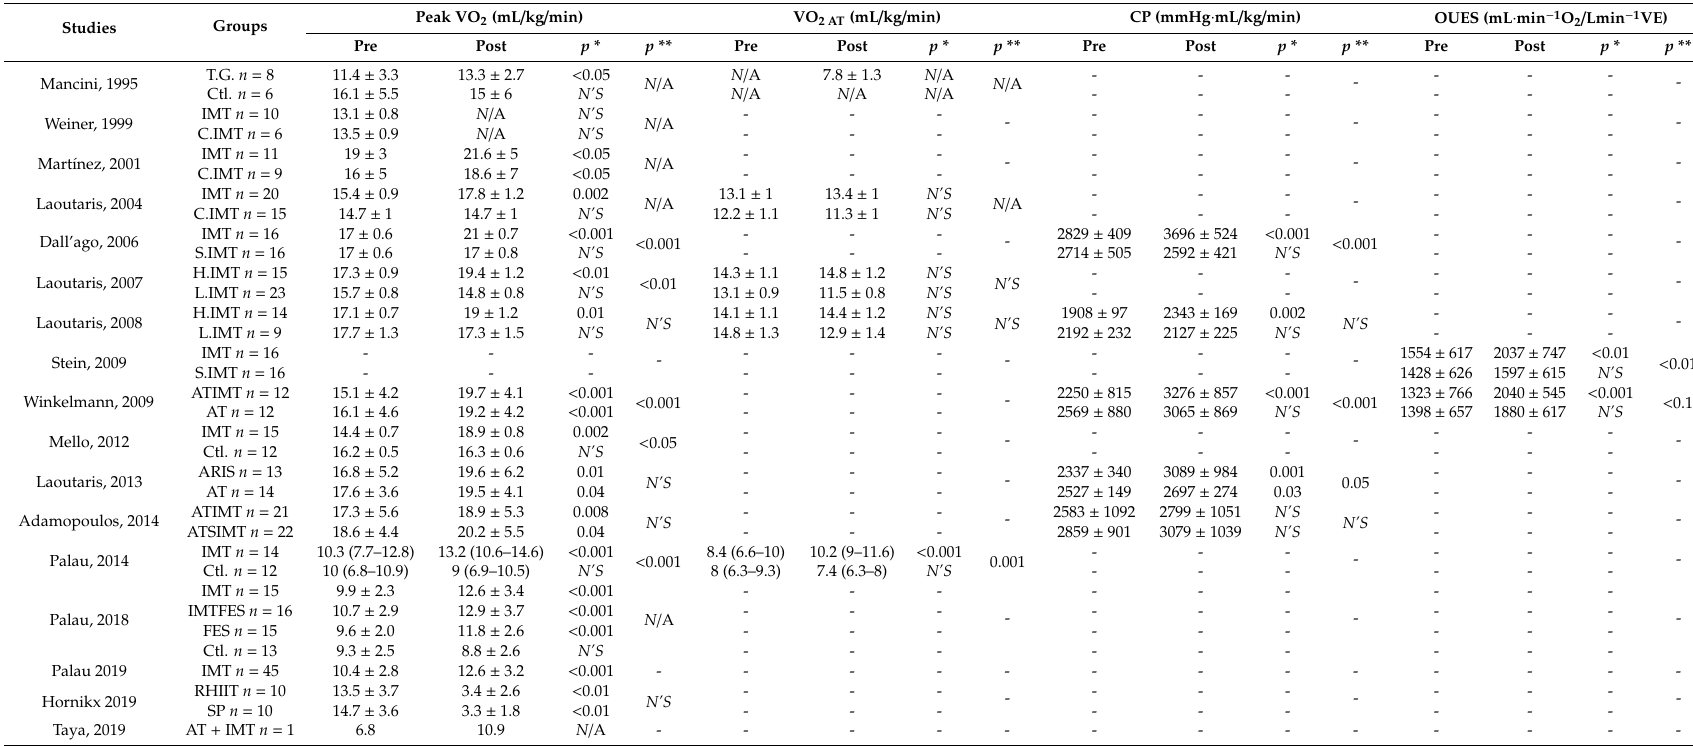
Table 5. Parameter related to VO